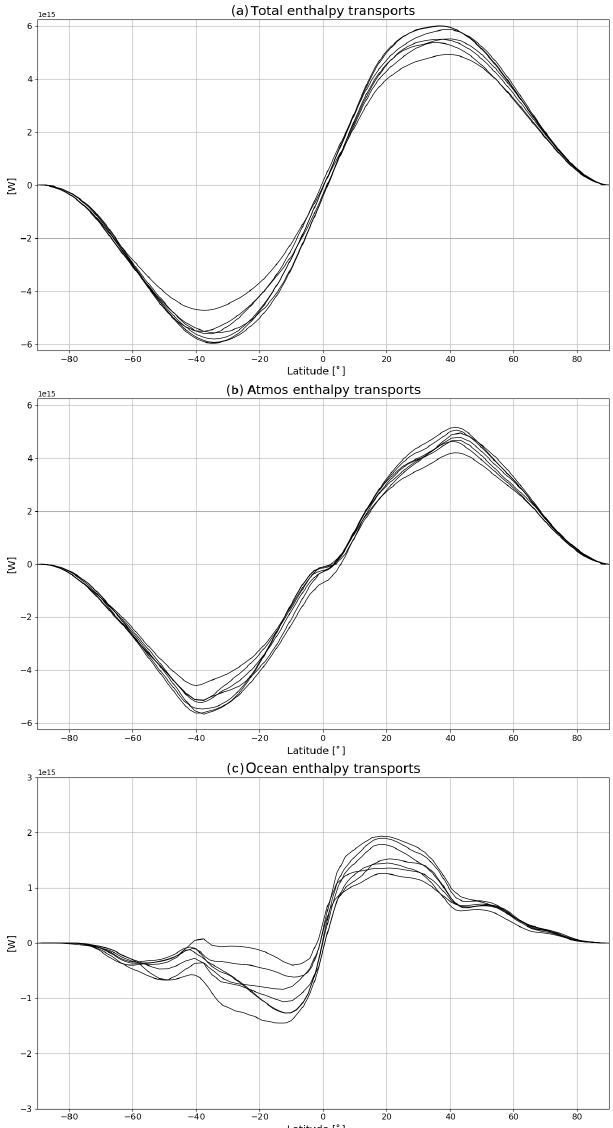
Figure 12. Annual mean meridional sections of zonal mean merid- ional total (a) , atmospheric (b) , and oceanic (c) heat transports for 12 CMIP5 models control runs. Transports are implied from merid- ionally integrating top-of-the-atmosphere (TOA), atmospheric, and surface energy budgets (Trenberth et al., 2001) and then applying the usual correction accounting for energy imbalances, as in Caris- simo et al. (1985). Values are in watts. Similar to Fig. 8 of Lembo et al. (2019) and produced with recipe_thermodyn_diagtool.yml ; see details in Sect.